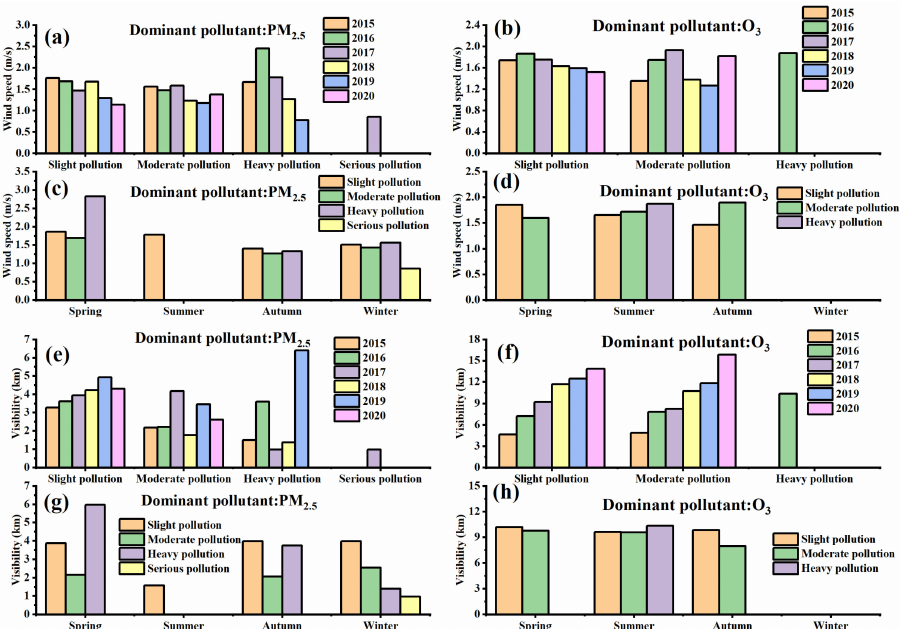
Figure 4. ( a ) Annual variations in wind speed at different air quality levels for the dominant pollutant PM 2.5 in 2015–2020; ( b ) Annual variations in wind speed at different air quality levels for the dominant pollutant O 3 in 2015–2020; ( c ) Seasonal variations in wind speed at different air quality levels for the dominant pollutant PM 2.5 in 2015–2020; ( d ) Seasonal variations in wind speed at different air quality levels for the dominant pollutant O 3 in 2015–2020; ( e ) Annual variations in visibility at different air quality levels for the dominant pollutant PM 2.5 in 2015–2020; ( f ) Annual variations in visibility at different air quality levels for the dominant pollutant O 3 in 2015–2020; ( g ) Seasonal variations in visibility at different air quality levels for the dominant pollutant PM 2.5 in 2015–2020; ( h ) Seasonal variations in visibility at different air quality levels for the dominant pollutant O 3 in